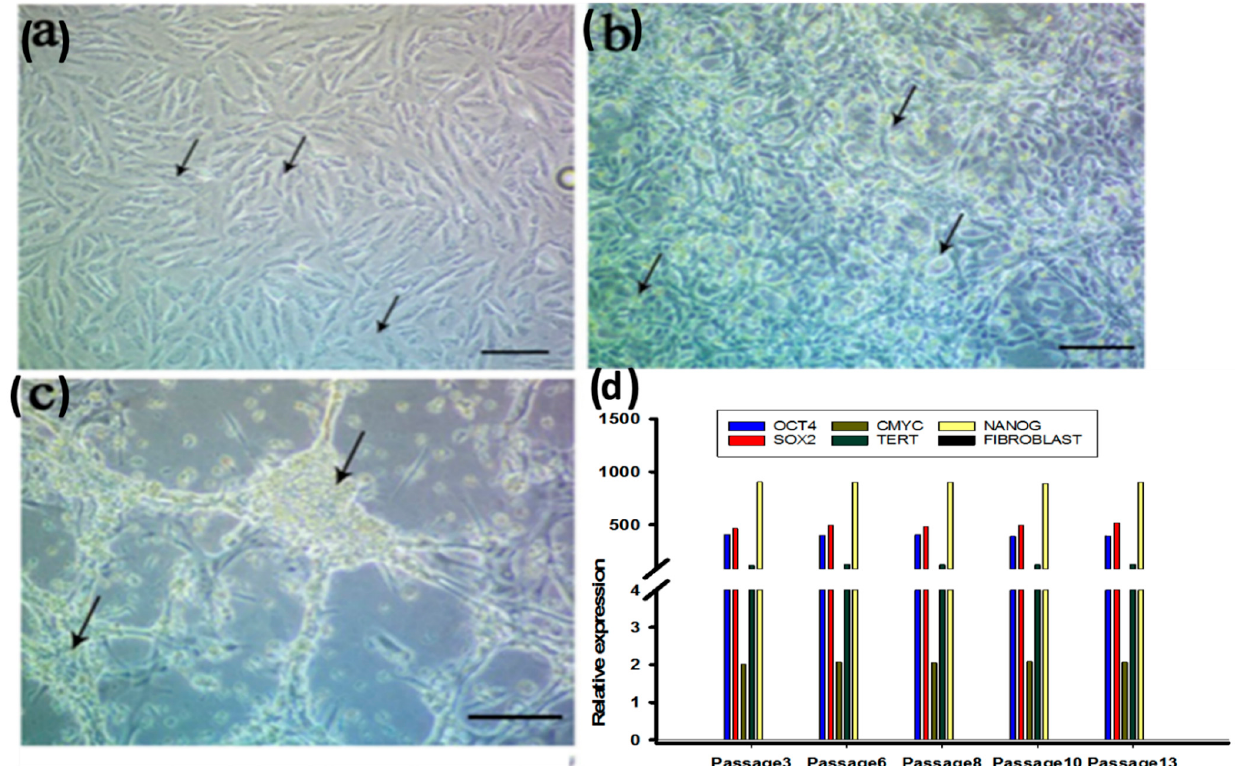
Figure 1. Representative images of livers during decellularization process at ( a ): 0 h; ( b ): 18 h;( c ): 48 h; ( d ) 72 h, and ( e ): 96 h. ( f ): DNA content analysis ; ( g ): glycosaminoglycans (GAGs) analysis of normal liver compared to decellularized